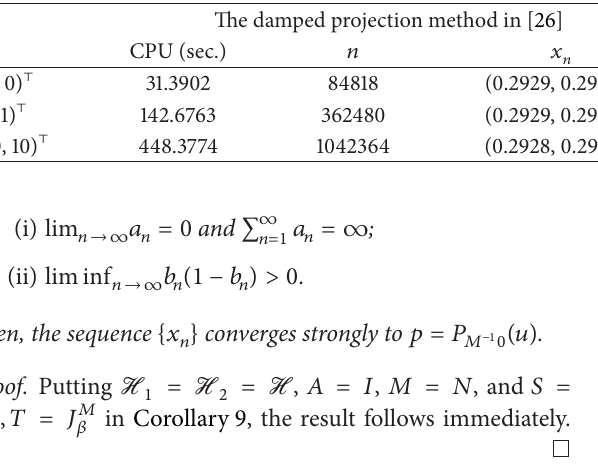
Table 2: Numerical results for Example